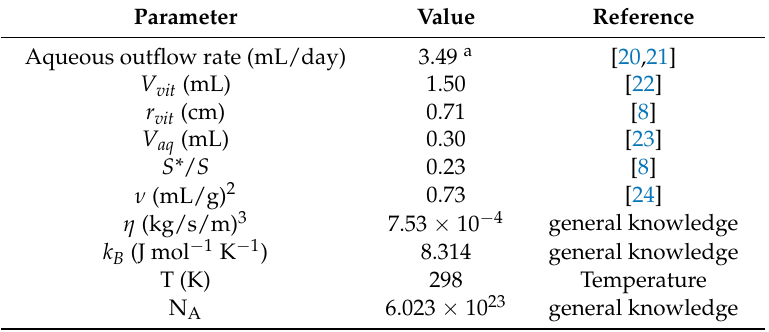
Table 1. Physical and anatomical parameter values in the